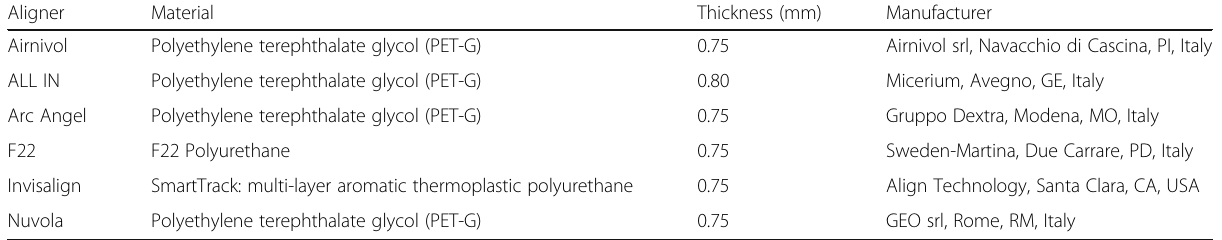
Table 1 List of six commercial aligner systems investigated, with the respective thicknesses and construction materials